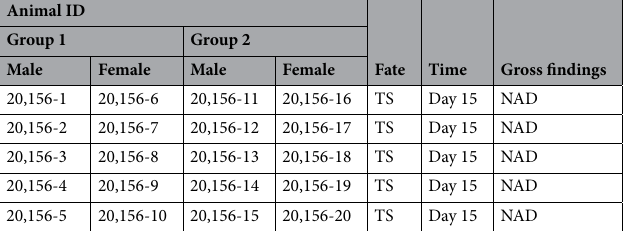
Table 8. Individual animal fate and necropsy findings. TS: terminal sacrifice, NAD: no abnormality detected, FD: found dead.